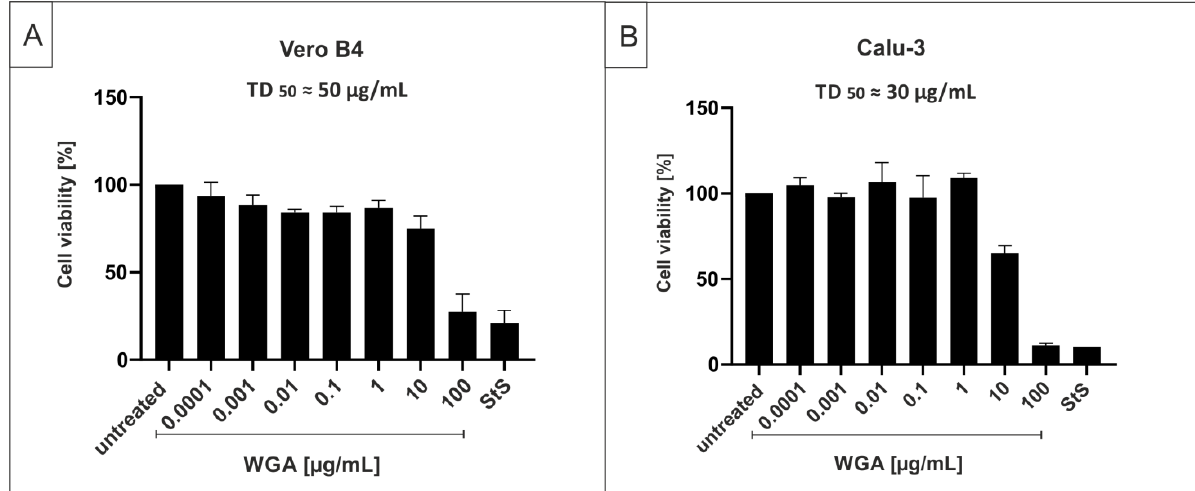
Figure 2. Influence of WGA on the cell viability of Vero B4 and Calu-3 cells. Vero B4 ( A ) or Calu-3 ( B ) cells were incubated with indicated concentrations of WGA. As a positive control, staurosporinean, an inducer of apoptosis, was added at a concentration of 10 µ M. Following treatment for three days, cell viability was measured by neutral red assays. Bars show mean values of five ( A ) or three ( B ) independent experiments ± standard